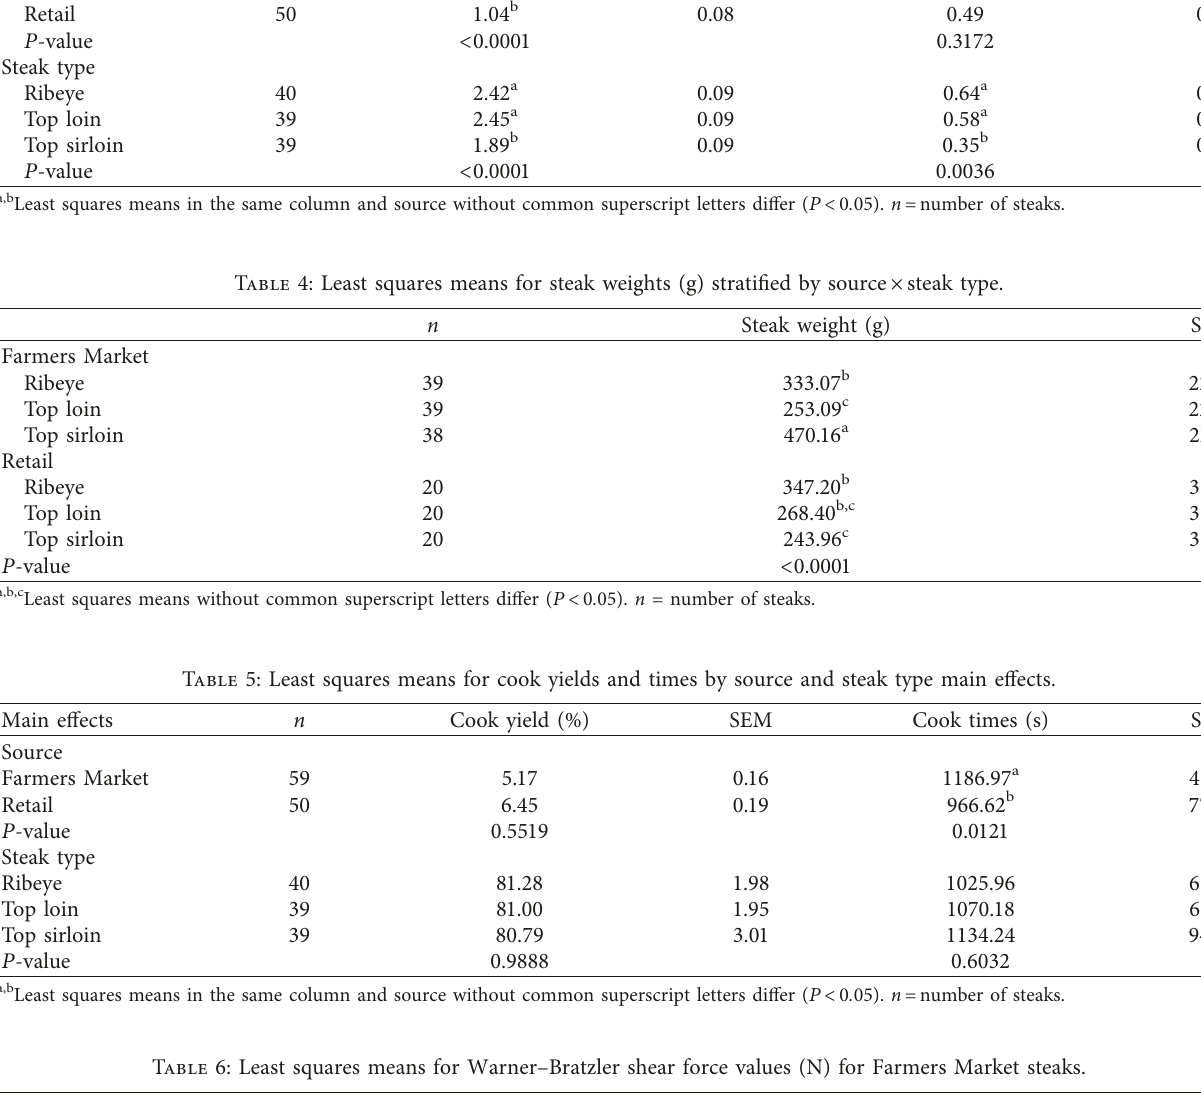
Table 6: Least squares means for Warner–Bratzler shear force values (N) for Farmers Market steaks. Steak type